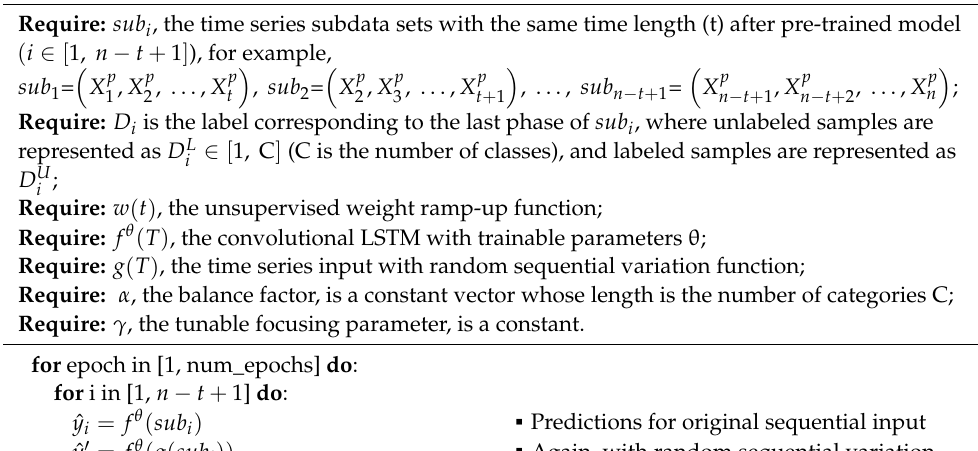
Figure 4. The process of semi-supervised learning and loss calculation of SemiLSTM. Algorithm 1. The training pseudocode of SemiLSTM.